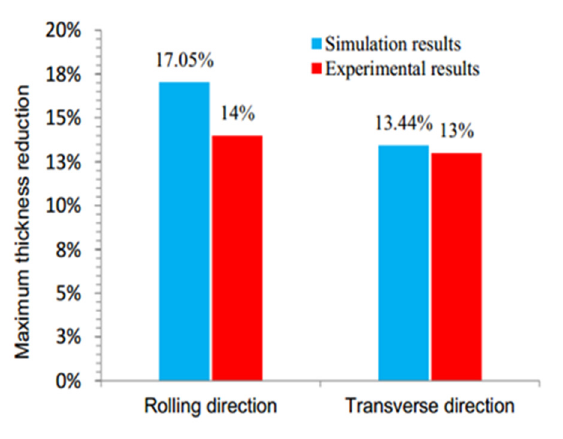
Fig. 17. Comparison punch load-displacement relation for both simulation and experiment.